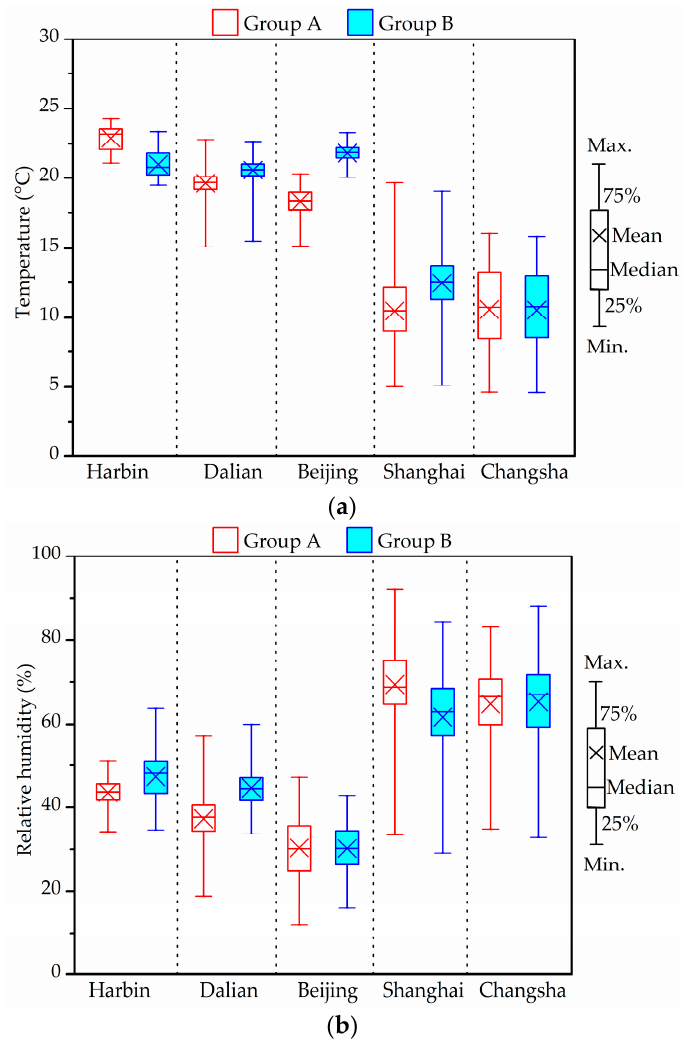
Figure 1. Statistical box plots of indoor temperature ( a ) and relative humidity (RH) ( b ) in two groups in winter.